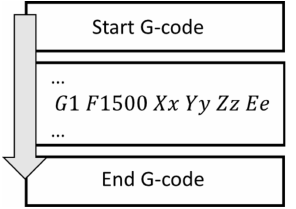
Figure 9. Parts of the G-code